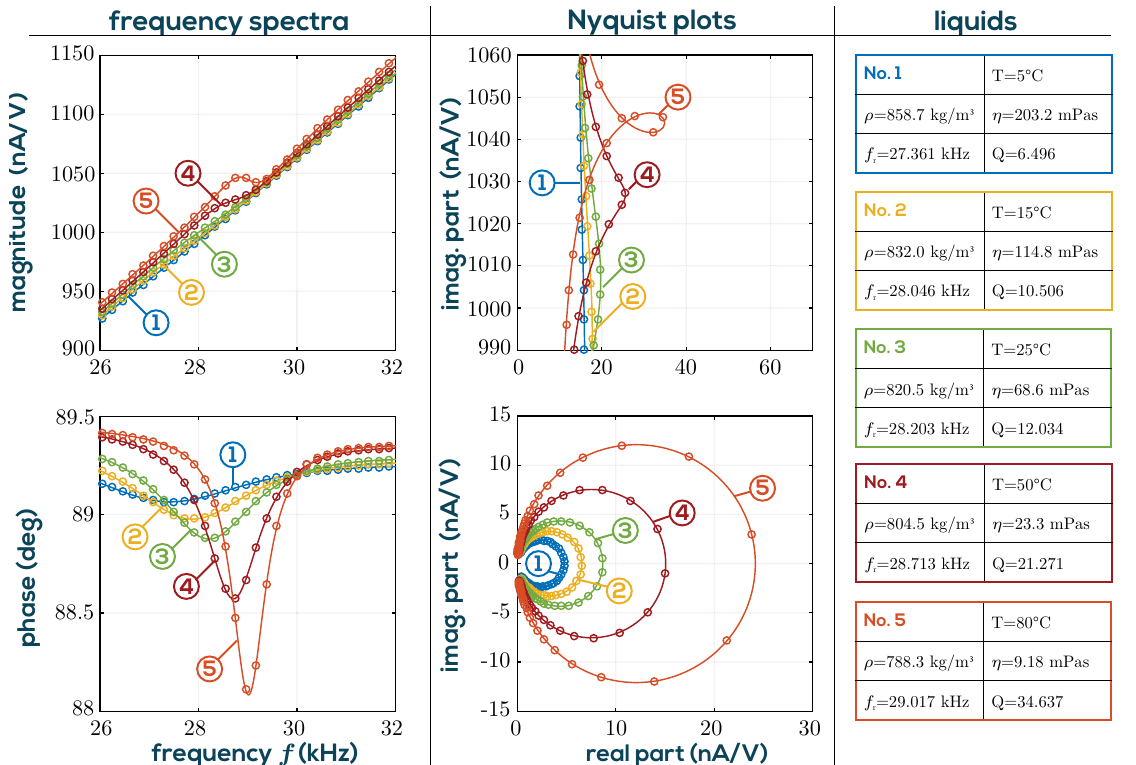
Figure 4. Frequency spectra of measured and fitted admittance signals for a silicone oil at varying liquid temperatures in the range from 5 ◦ C to 80 ◦ C are shown in the left two plots. The signals are dominated by the linear slope of C 0 in the magnitude, and only the small phase shifts indicate resonances. The above middle figure shows the associated Nyquist plots. In the lower middle figure, the background signals were subtracted, leaving only the motional branch admittance, which resemble circles. The solid lines are results of the resonance estimation algorithm, and the markers show the data points recorded using the system in Figure 6. On the right, the liquids corresponding to the labels (1–5) and the measured resonance parameters are